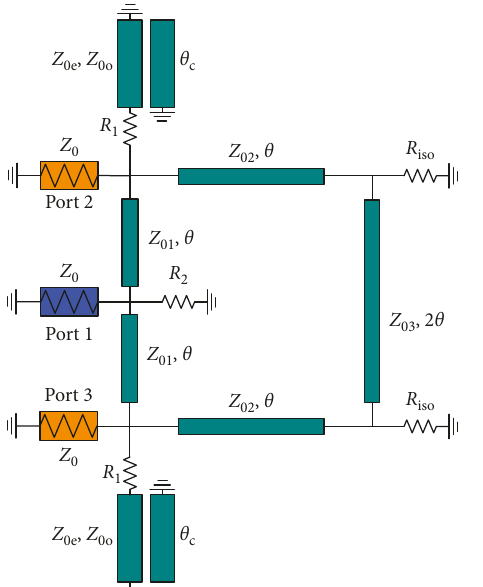
Figure 1: Configuration of the proposed NGD Gysel power divider.